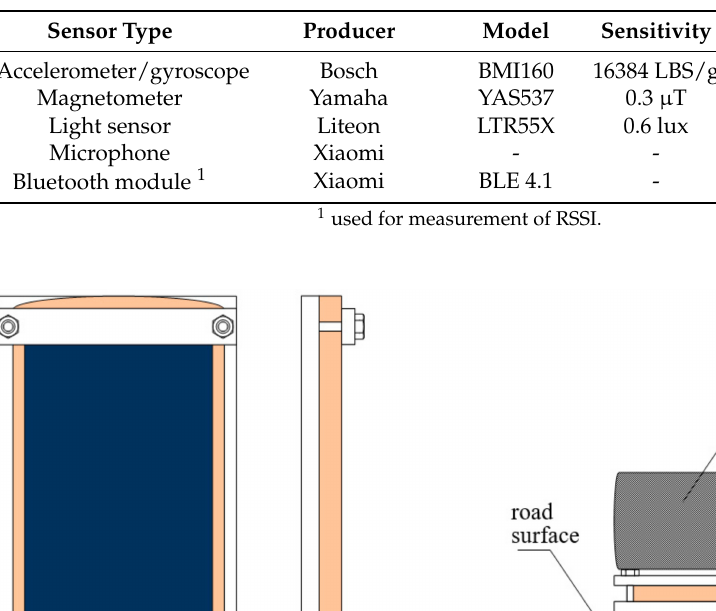
Table 4. Built-in sensors of SN1.